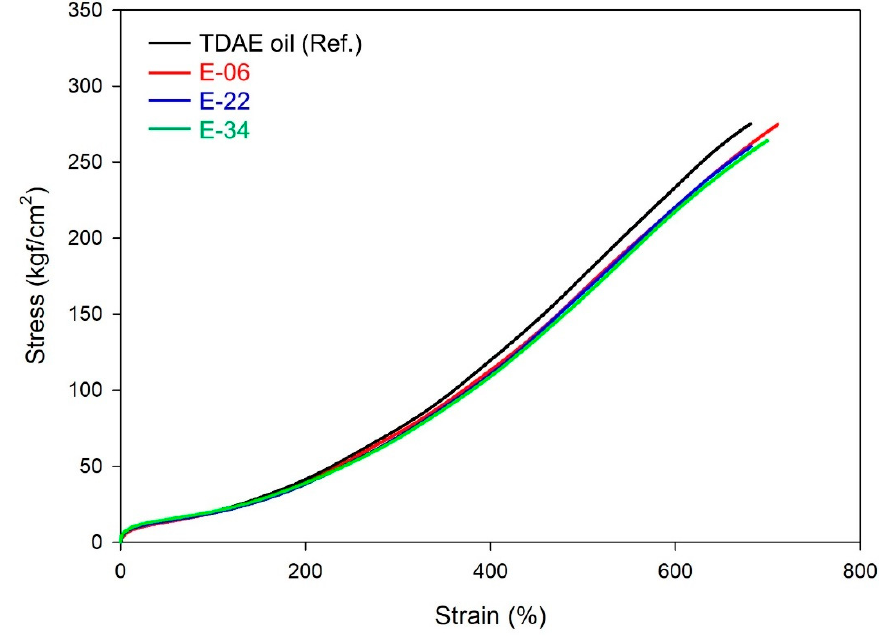
Figure 7. Stress–strain curves of the vulcanizates. Table 7. Mechanical properties of the vulcanizates.